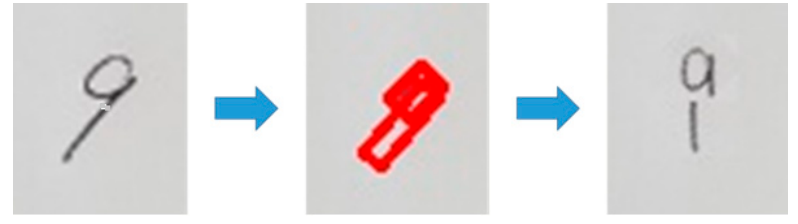
Figure 23. Example of an error in the circumscribed rectangle generation.